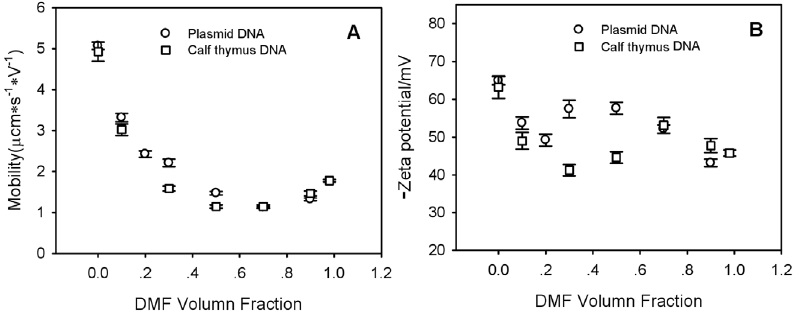
Figure 7. DMF-content dependence of zeta potential measurements of calf thymus DNA and plasmid DNA.